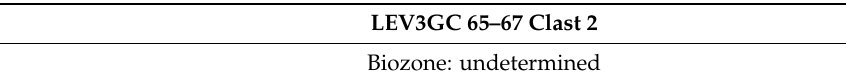
Table A16. Heraklion